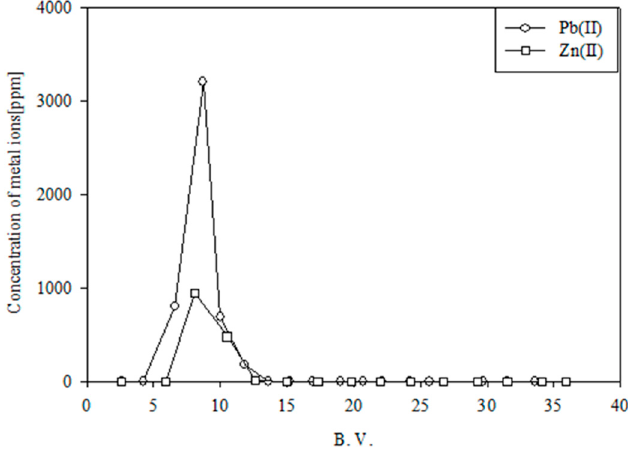
Figure 10. Pb(II) and Zn(II) elution profiles when the column loaded with Pb(II) and Zn(II) in the